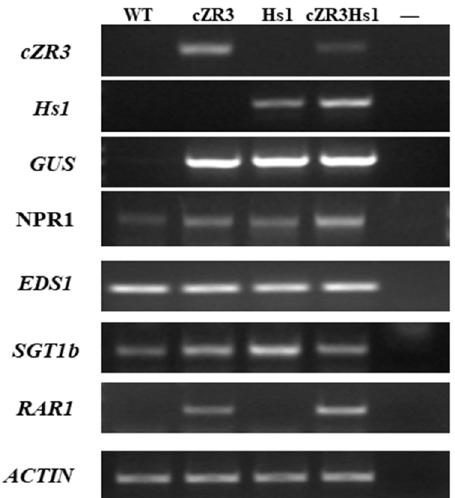
Figure 7. Expression of the key defense related genes in wild-type, transgenic cZR3 and Hs1 pro-1 , and cZR3Hs1 pro-1 gene pyramiding plants. The expression levels of cZR3 , Hs1 pro-1 , GUS , NPR1 , EDS1 , SGT1 and RAR1 were determined by semi-quantitative RT-PCR with independent transgenic and pyramiding lines, while oilseed rape wild type zheshuang 758 served as control. “–“ represents the negative control.